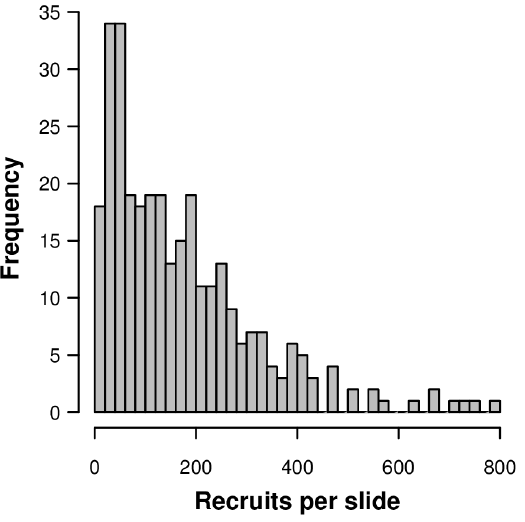
Figure 3. Histogram showing the frequency of kelp recruit counts on the cover